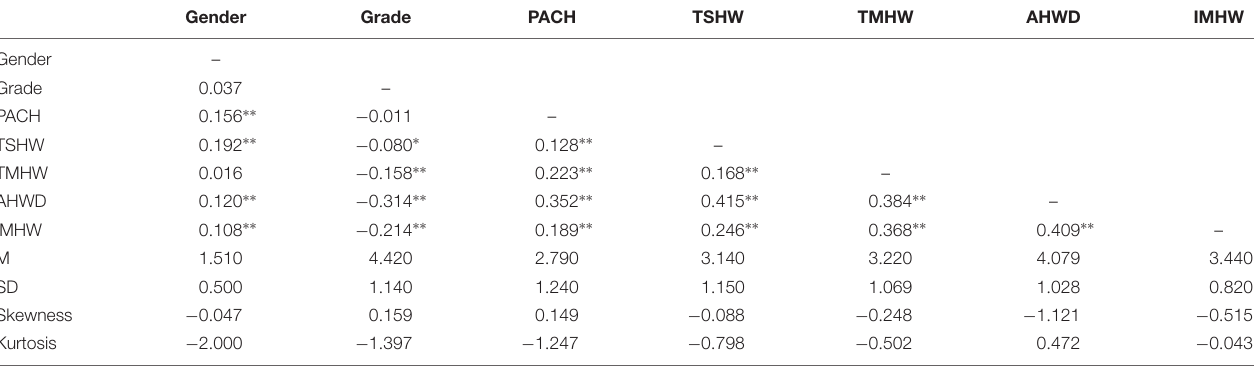
FIGURE 1 | A simple mediation and moderation conceptual models of intrinsic motivation (IM) in the effect of prior achievement (PACH) on student behavioral engagement in homework (SBEH). TABLE 1 | Descriptive statistics (mean, standard deviation, skewness, kurtosis) and Pearson correlation matrix. Gender Grade PACH TSHW TMHW AHWD